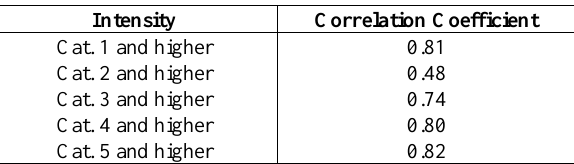
Table 7. Correlation coefficients of relations between averaged MYM and averaged hurricane frequencies, computed on different SSHWS